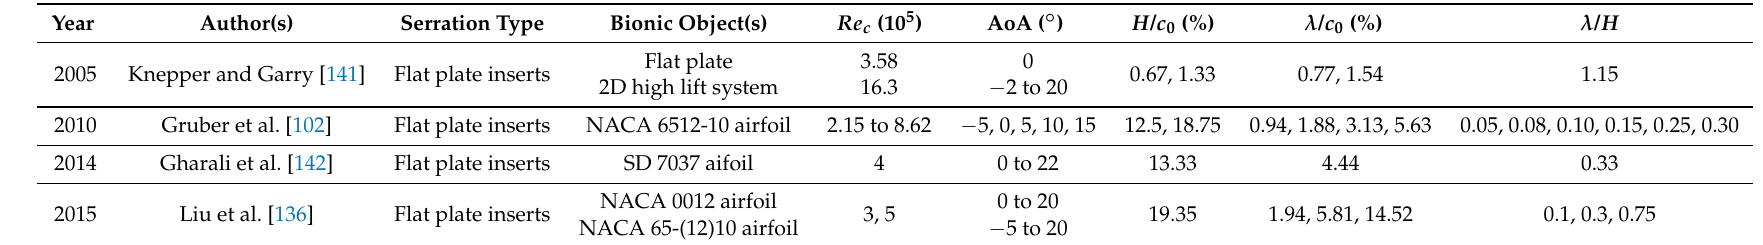
Table 6. Selected investigations of aerodynamic effect of trailing edge serrations.